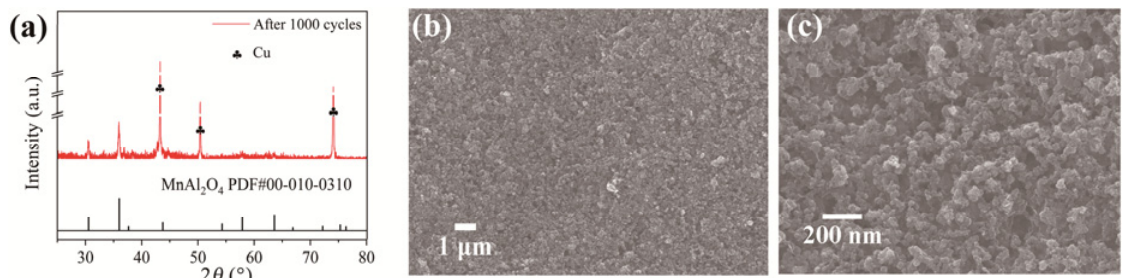
Fig. 8 (a) XRD pattern and (b, c) SEM images in different magnifications of the 6M-HEO-950 sample after 5000 cycles of